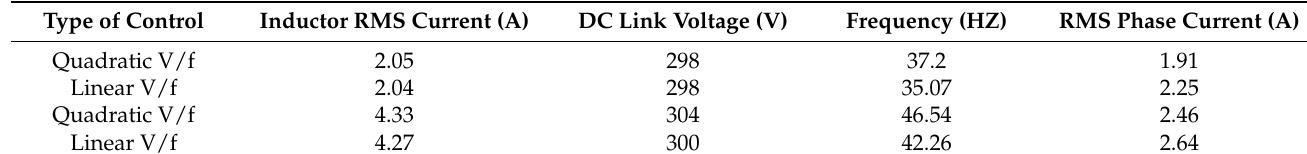
Table 6. Experimental results for Q V/f PI-PI compared to L V/f PI-PI.